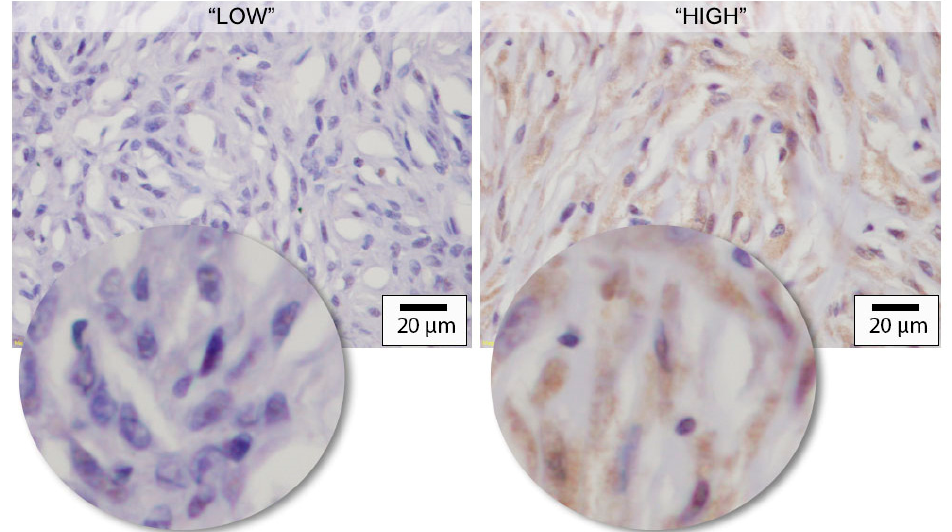
Figure 1. Grading scale of immunostaining for vascular endothelial growth factor (VEGF). The expected immunostaining pattern for VEGF was a strong, cytoplasmic stain. A low VEGF score was assigned if less than 75% of cells were immunostained. For a high VEGF tumour, more than 75% of the cells showed positive immunostaining (main image: 40× objective; inset images are unscaled digital enlargements for illustrative purposes).